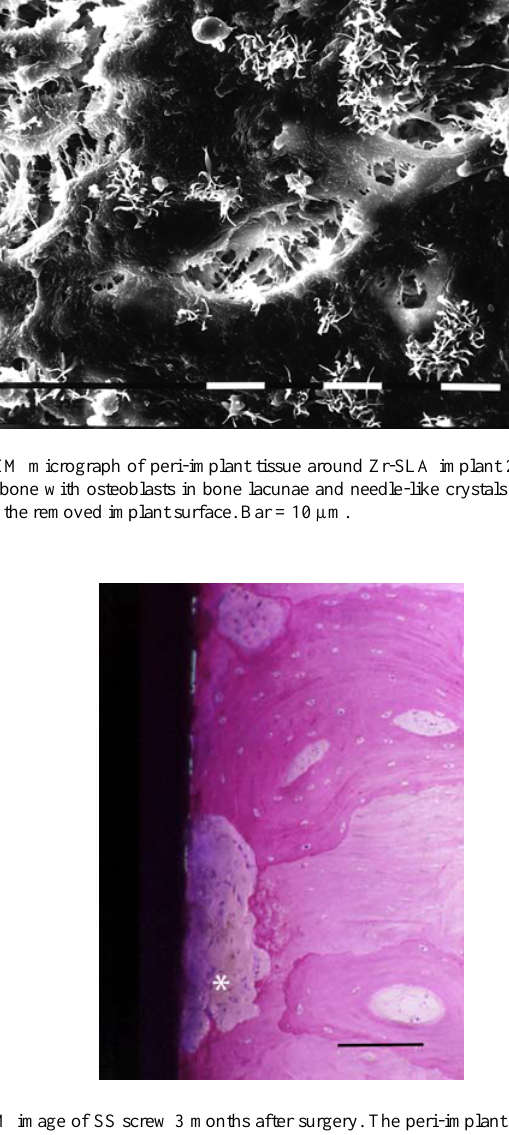
FIGURE 7 . LM image of SS screw 3 months after surgery. The peri-implant bone in direct contact with the implant is a mature lamellar bone with osteons. A small marrow space (*) rich in blood vessels and cells is visible in direct contact with the metal. Bar = 100